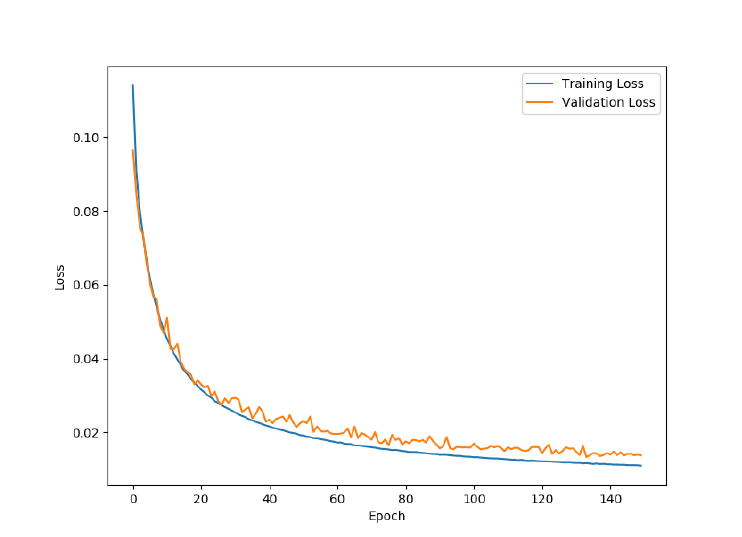
Figure 9. Training loss and validation loss in the training process. After approximately 100 epochs, the model loss remains largely constant, and the training process can be stopped at this